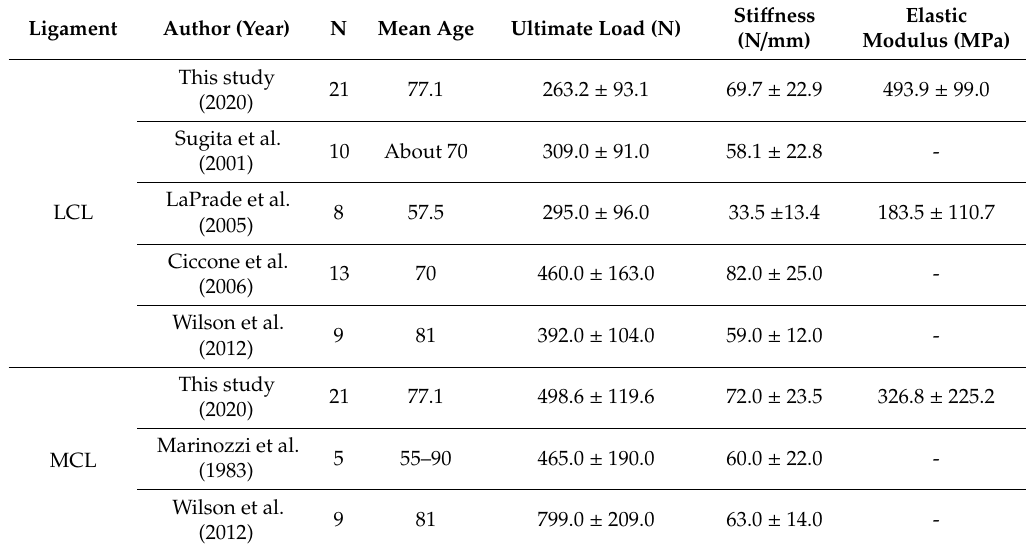
Table 7. Comparisons of the mechanical properties of the LCL and